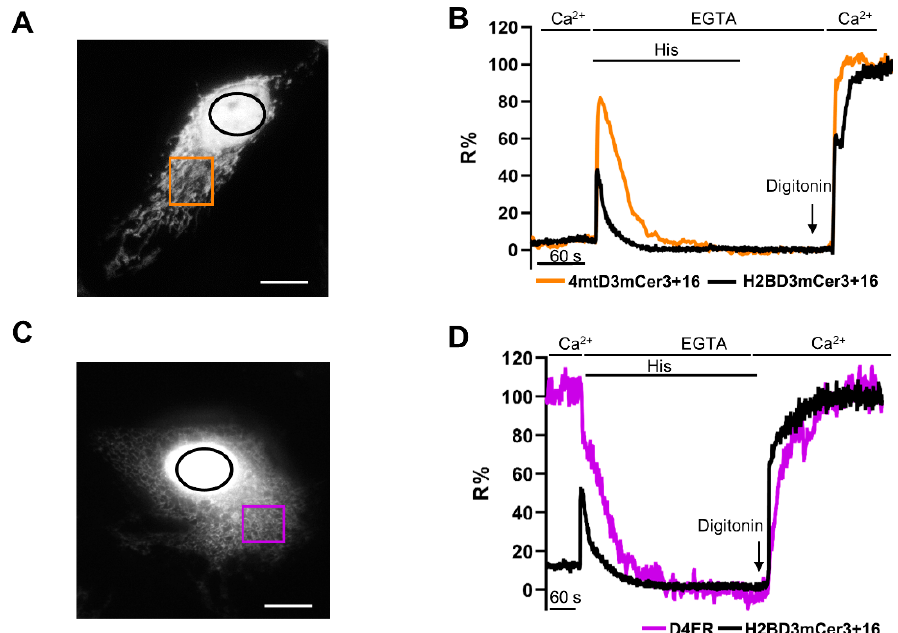
Figure 5. Simultaneous imaging of nuclear and organelle Ca 2+ kinetics. ( A – C ) Representative image of the acceptor channels of HeLa cells coexpressing H2BD3mCerulean3+16 (black) and 4mtD3mCerulean3+16 ( A , orange) or D4ER ( C , purple). The fluorescence of H2BD3mCer3+16 was saturated to better visualize mitochondria ( A ) and ER ( C ) fluorescence signals. ( B – D ) Representative kinetics of nuclear and mitochondria ( B ) or ER ( D ) R% values in a HeLa cell coexpressing H2BD3mCerulean3+16 and 4mtD3mCerulean3+16 ( B ) or D4ER ( D ) stimulated with histamine, as described in Figure 4B. Data are presented as R% values, as described in Section 4.